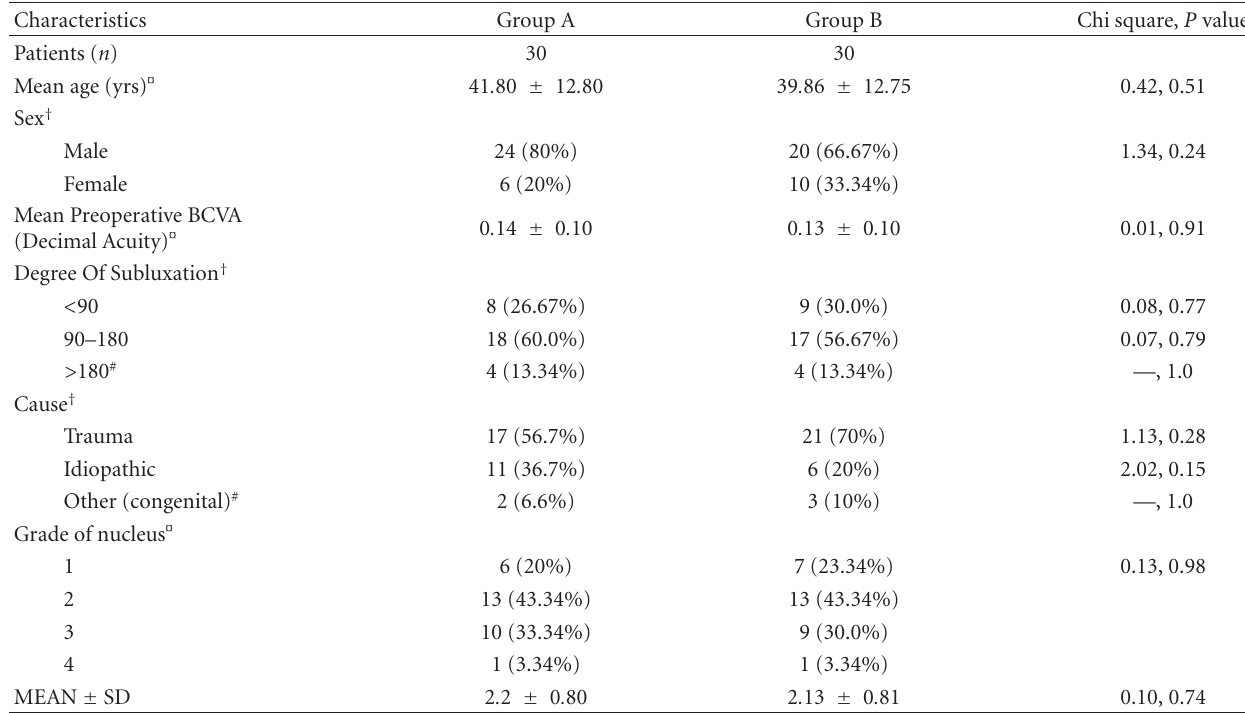
Table 1: Preoperative comparison of two